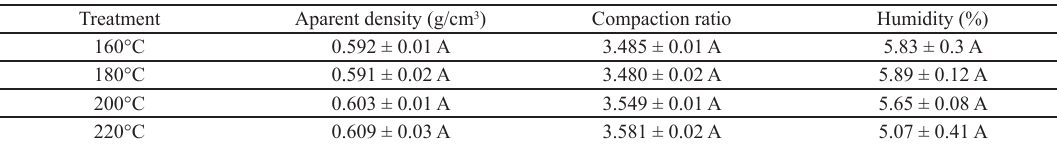
Table 3. Apparent density, compaction ratio and humidity of panels produced as a function of pressing temperature.